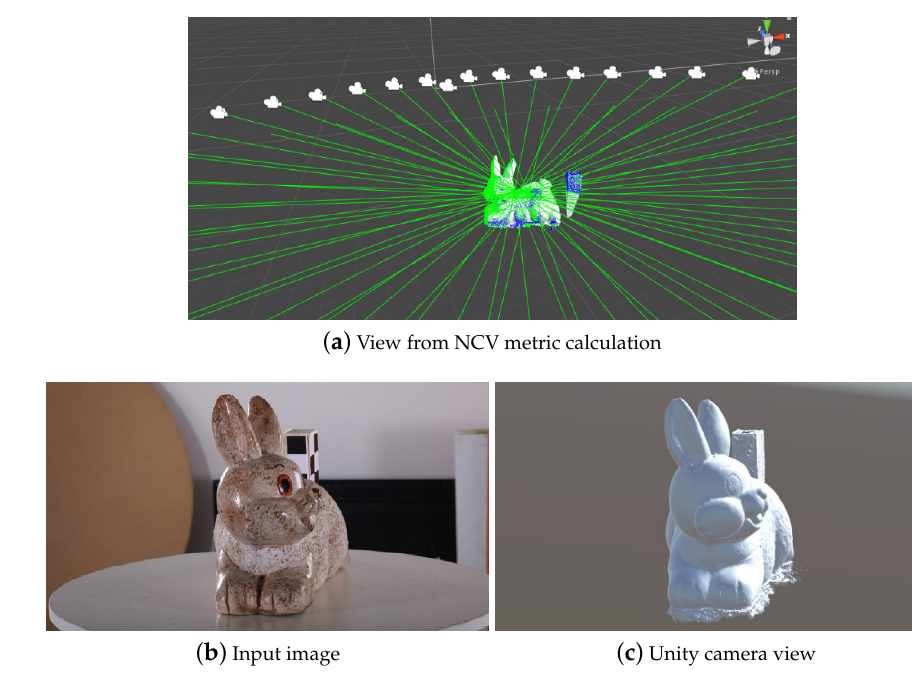
Figure 7. Overview of the implementation pipeline, showing what input and programming environments are used to calculate each of the metrics. The mesh-based metrics are directly computed in Python, while the capturing-setup based ones use a combination between Python and the Unity game engine.